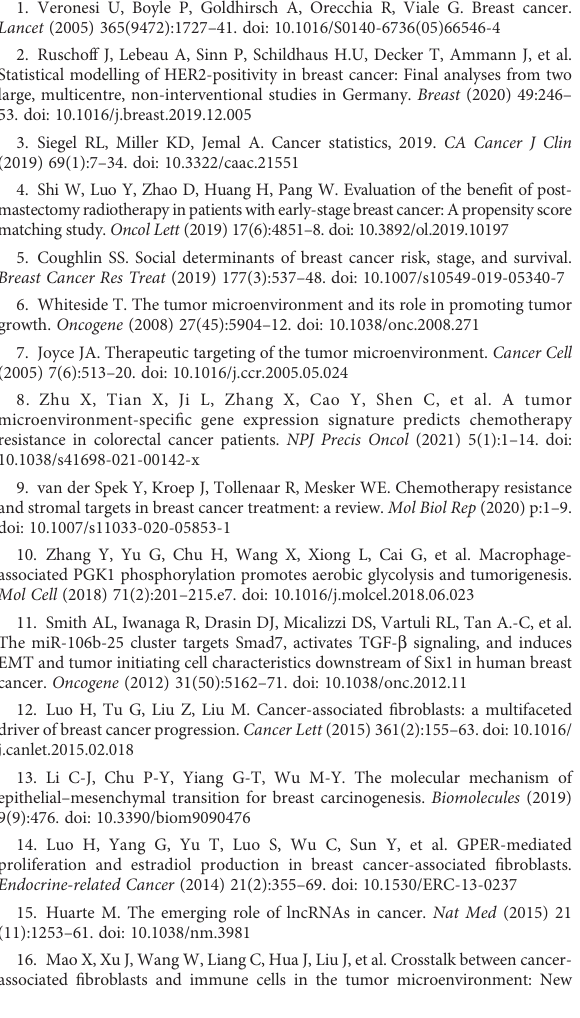
FIGURE S6 Mutation landscape difference between high- and low-risk subgroups. FIGURE S7 Mutation co-occurrence and mutually exclusive patterns difference between high and low-risk subgroups. FIGURE S8 (A) Correlation analysis of synonymous mutation counts and nonsynonymous mutation counts and FibLnc scores. (B) Correlation analysis of PD-1 and CTLA4 expressionvalueandFibLncscores. (C) DistributionofIPSscoreofpatientsunder anti-CTLA-4oranti-PD-1treatmentbetweenhigh-andlow-risksubgroups. TABLE S1 Stromal and immune in fi ltration levels of TCGA BRCA samples calculated by ESTIMATE algorithm.